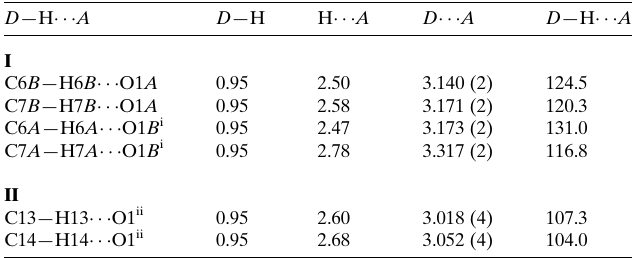
Table 1 Short intermolecular C—H (cid:2)(cid:2)(cid:2) O contacts (A˚ , (cid:3) ) in I and II . D —H (cid:2)(cid:2)(cid:2) A